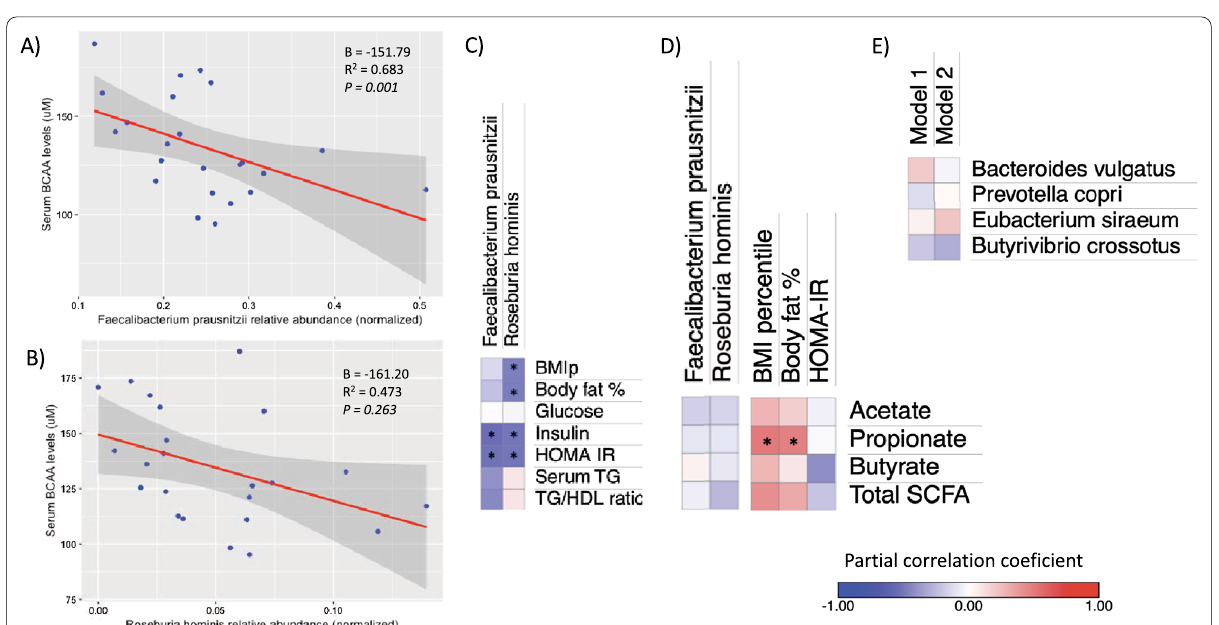
Fig. 4 Associations of metagenomic species with serum BCAA, metabolic traits and fecal SCFA. A , B multiple linear regression models for the association between the arcsin‑sqrt normalized abundance of Faecalibacterium and Roseburia species and serum BCAA levels adjusting for age, sex and body fat percentage. B heat map of the partial Spearman’s rank correlation coefficient between species relative abundance and metabolic traits. C Heat map of the partial Spearman’s rank correlation coefficient of fecal SCFA concentrations with species abundance and metabolic traits. A , B regression models were adjusted for age, sex and body fat percentage, gray shading represents 95% CI. C , D partial correlations for anthropometric traits were adjusted for age and sex, and for biochemical variables were further adjusted for body adiposity. E heat map of the partial Spearman’s rank correlation coefficient between selected species and total serum BCAA levels. P‑values were calculated using partial correlations adjusted for Model 1: age and sex. Model 2: Model 1 body fat percentage. *P < 0.05. BCAA branched‑chain amino acids, SCFA + short‑chain fatty